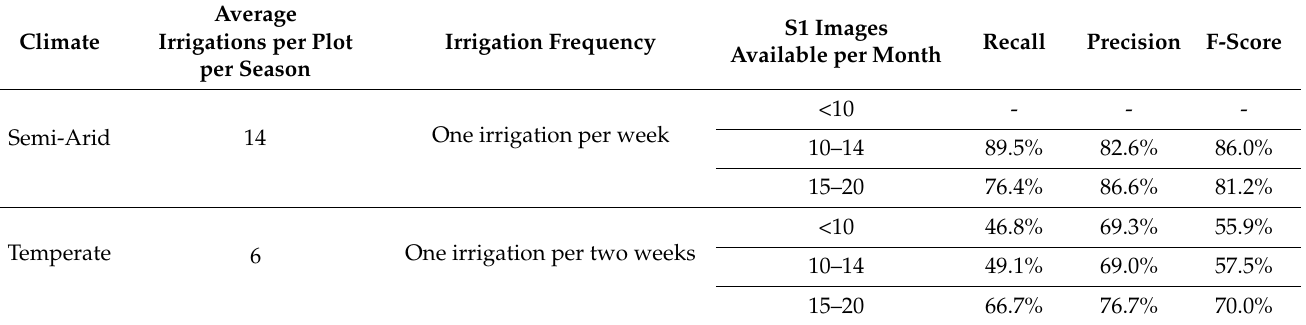
Table 6. Recall, precision and F-score values per class of available S1 images for each climatic